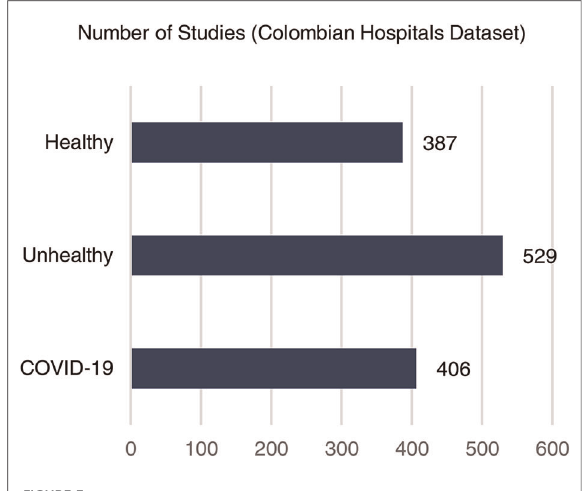
FIGURE 3 Data distribution of the CT studies collected from Colombian medical